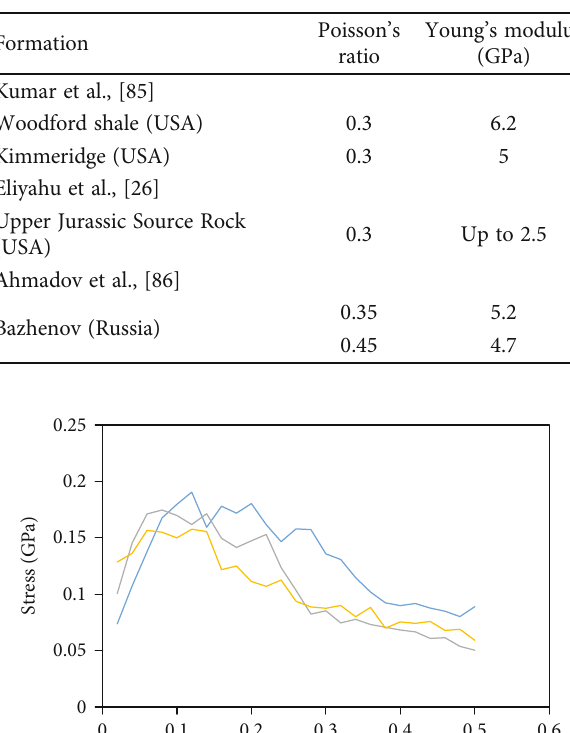
Table 3: Experimental assessments of Young ’ s modulus and Poisson ’ s ratio of kerogen samples taken from di ff erent shale formations.